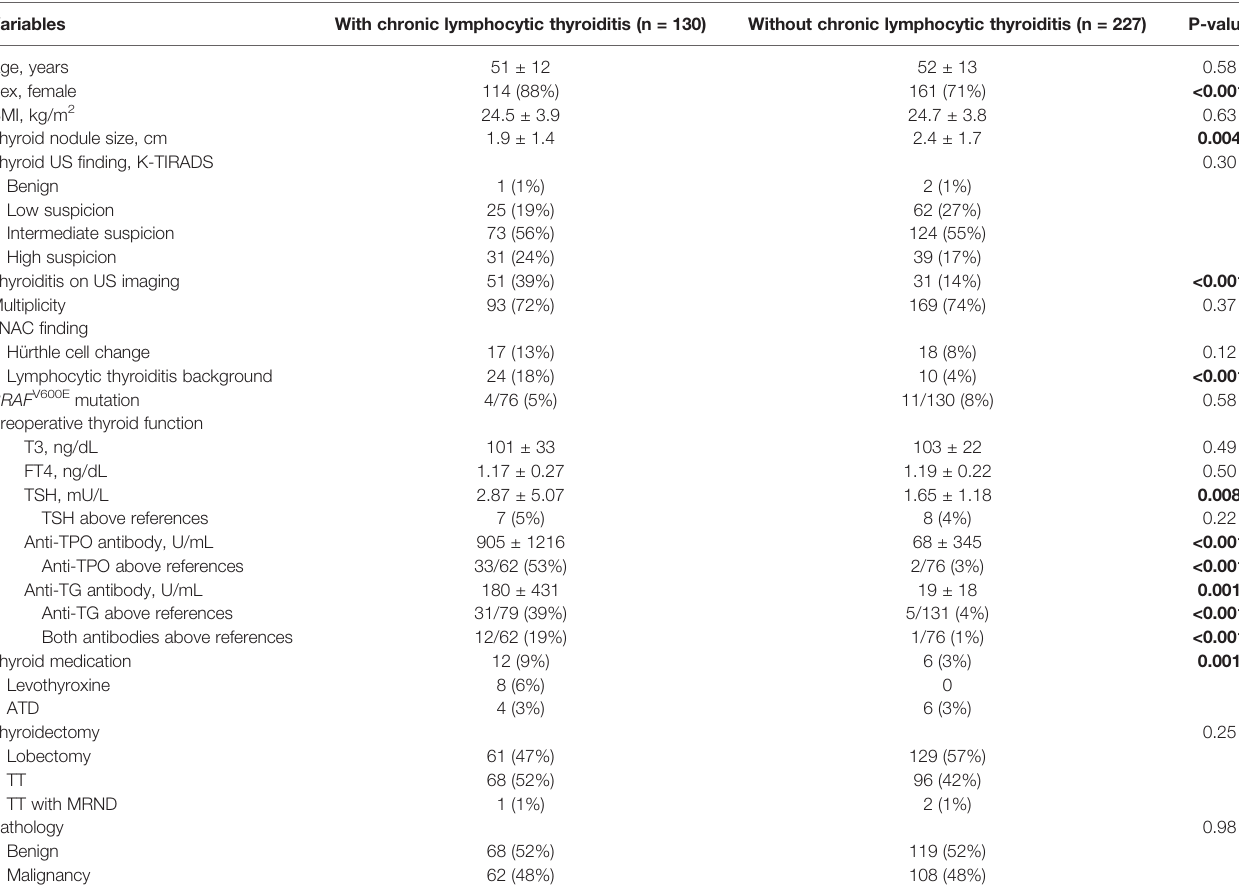
TABLE 1 | Baseline characteristics of 357 Bethesda class III thyroid nodules.